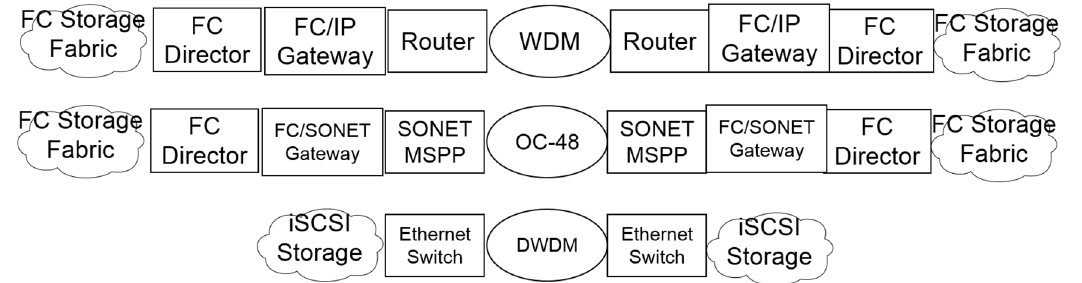
Figure 5. Comparison of network architectures for Fibre Channel over Internet Protocol FC-IP ( top ); Fibre Channel over Synchronous Optical Network FC-SONET ( middle ); and native iSCSI ( bottom